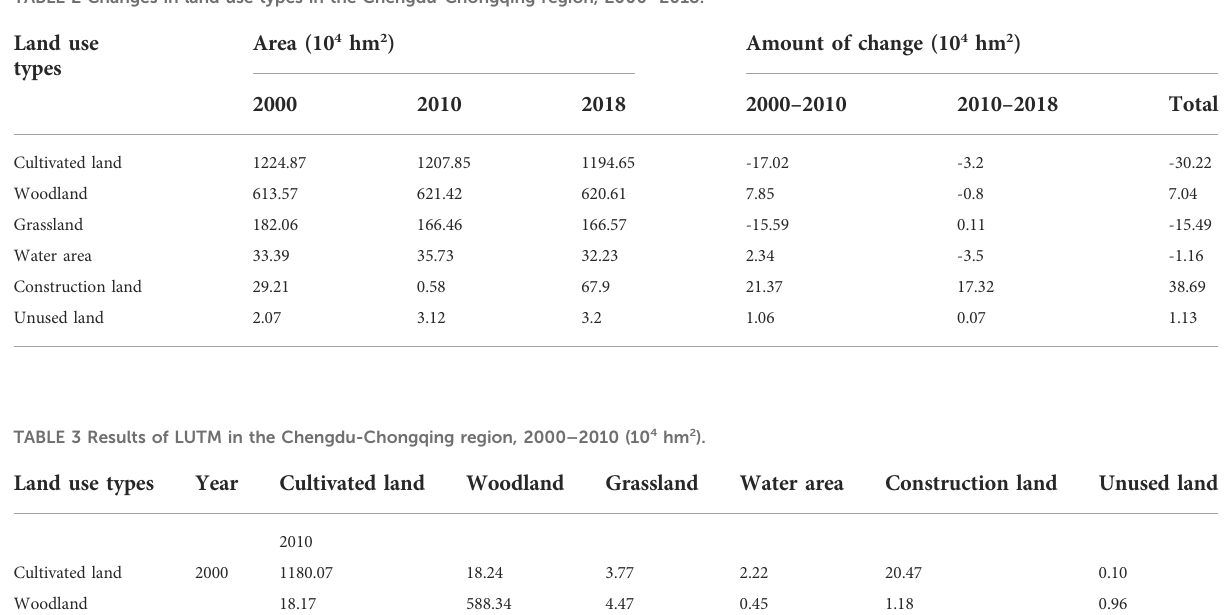
TABLE 2 Changes in land use types in the Chengdu-Chongqing region, 2000 –